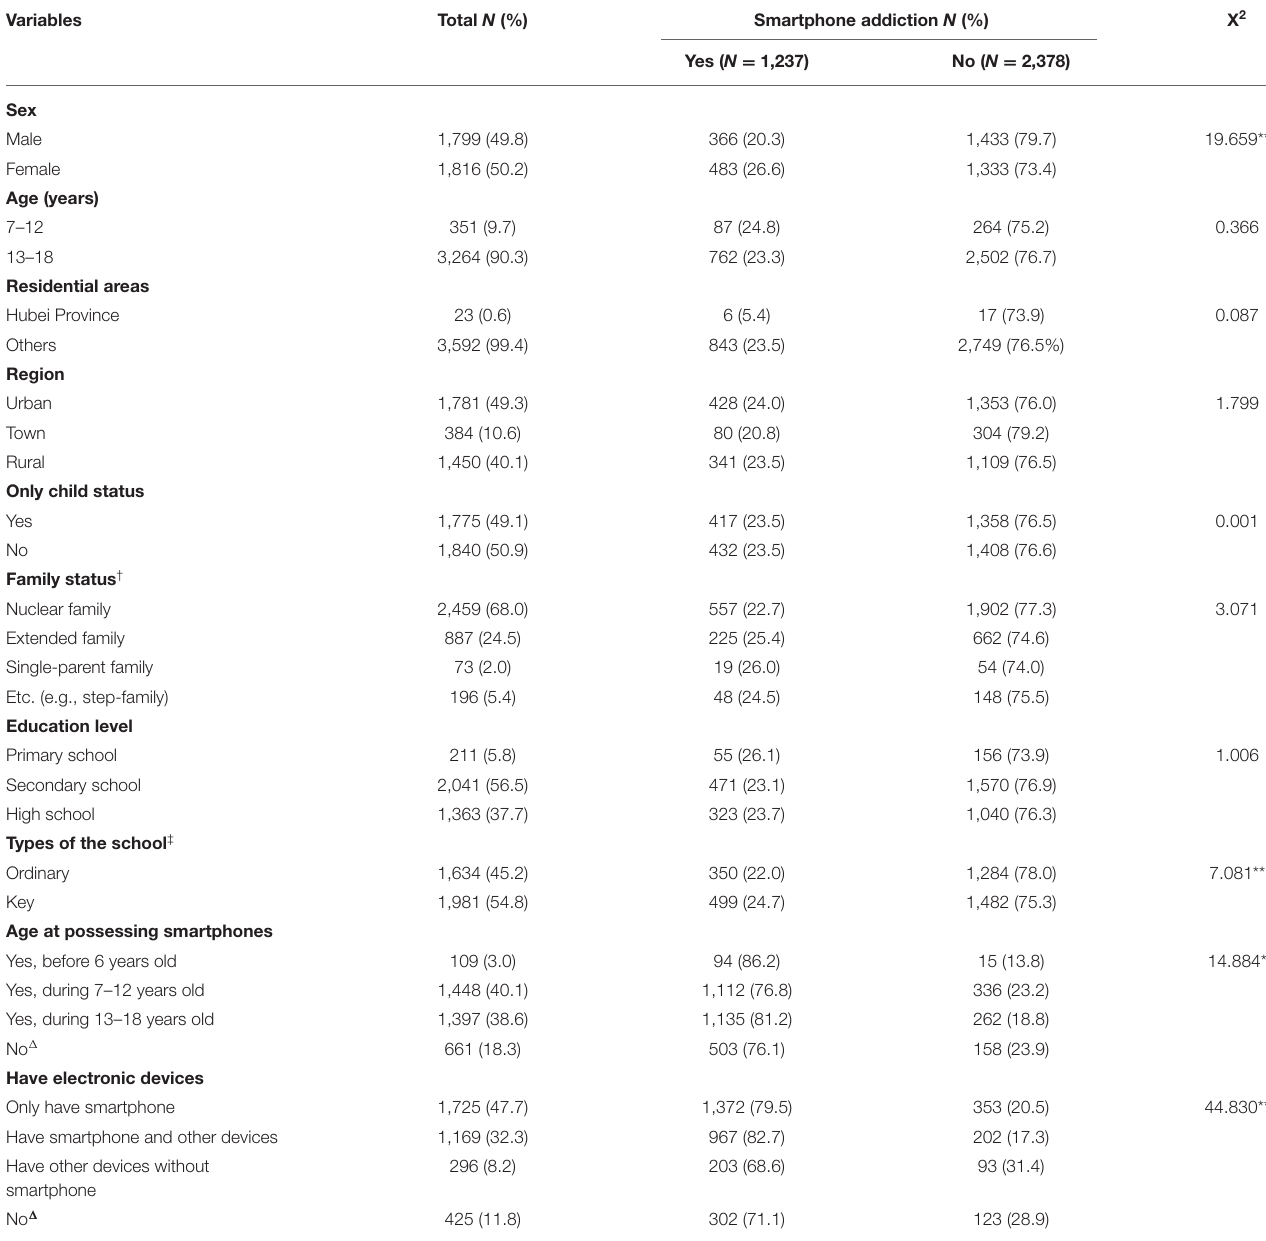
TABLE 1 | Frequencies and chi-square test of smartphone addiction and non-addicts on social-demographic characteristics ( N = 3,615).